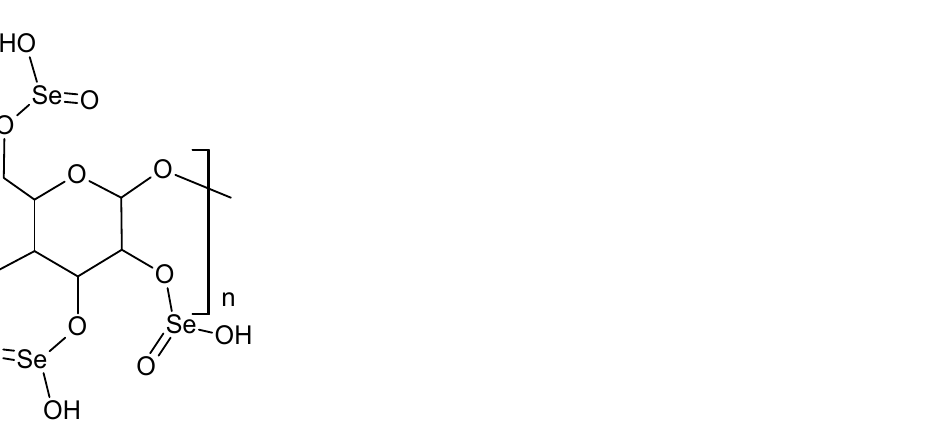
Figure 10. Theoretical structure of the polyglucopyranose with three hydroxyl groups per monomer acylated by selenious acid (DS = 3).